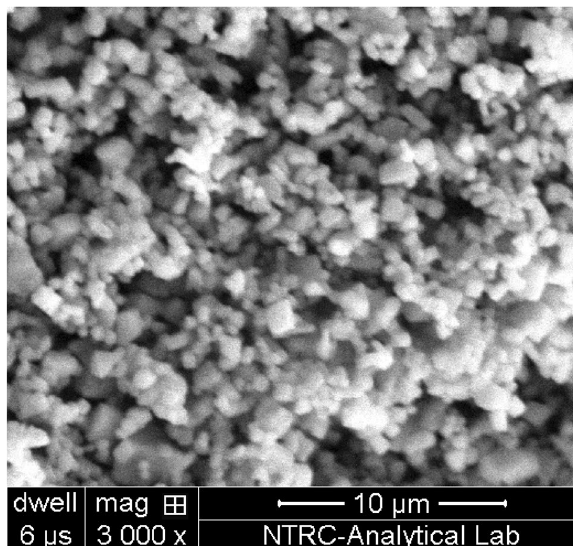
Figure 3. SEM micrograph of TiO 2 nanoparticles.